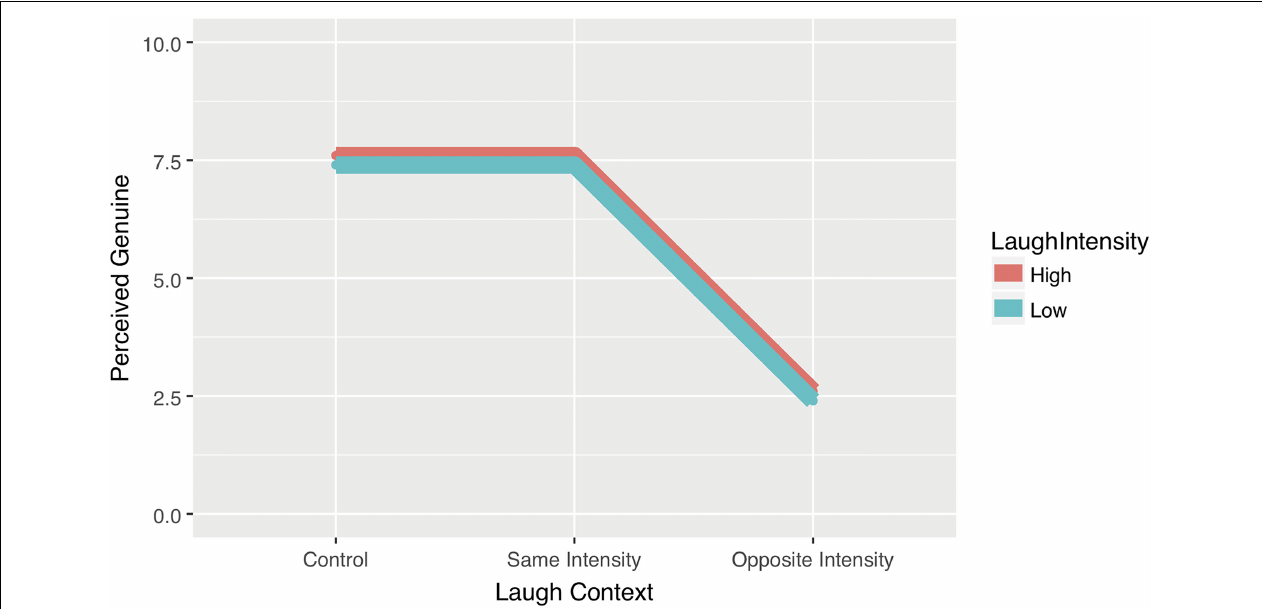
FIGURE 2 | Hypothesised pattern of results for Experiment 1: Interchanged laughter leads to perceptions of genuine interactions when intensity is the same but not when intensity is different.